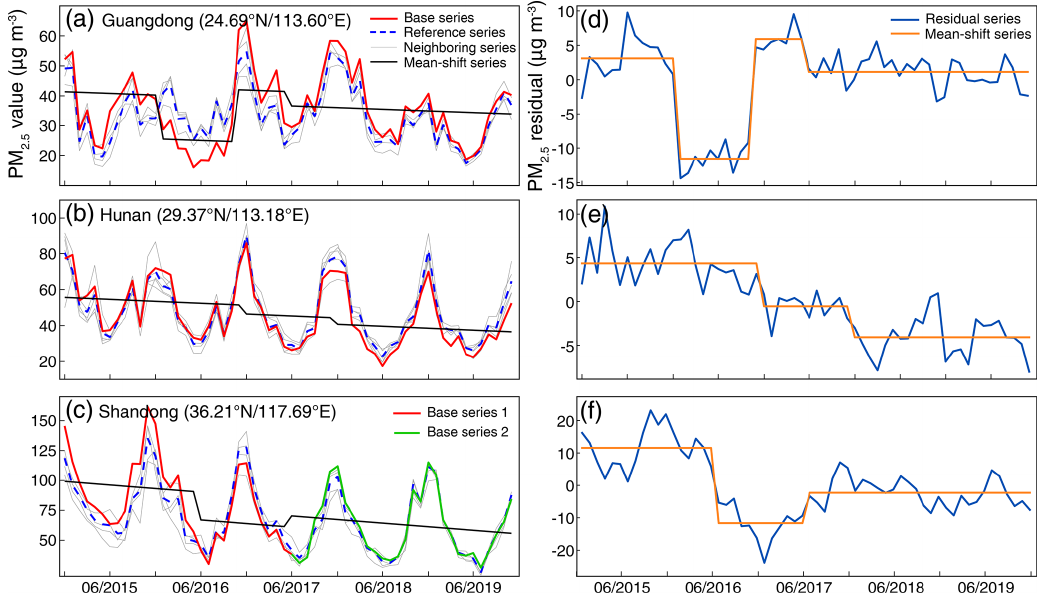
Figure 5. Temporal variations of three typical inhomogeneous PM 2 . 5 concentration records during 2015–2019. (a, d) Significant deviations during a short time period, (d, e) long-term chronic drifts with statistically significant varying trend detected in the residual series, (c, f) discontinuity due to site relocation. The left panels compare the base series with the reference and the neighboring series used to compose the reference while the right panels show the residual series between the base and reference series as well as their mean-shift